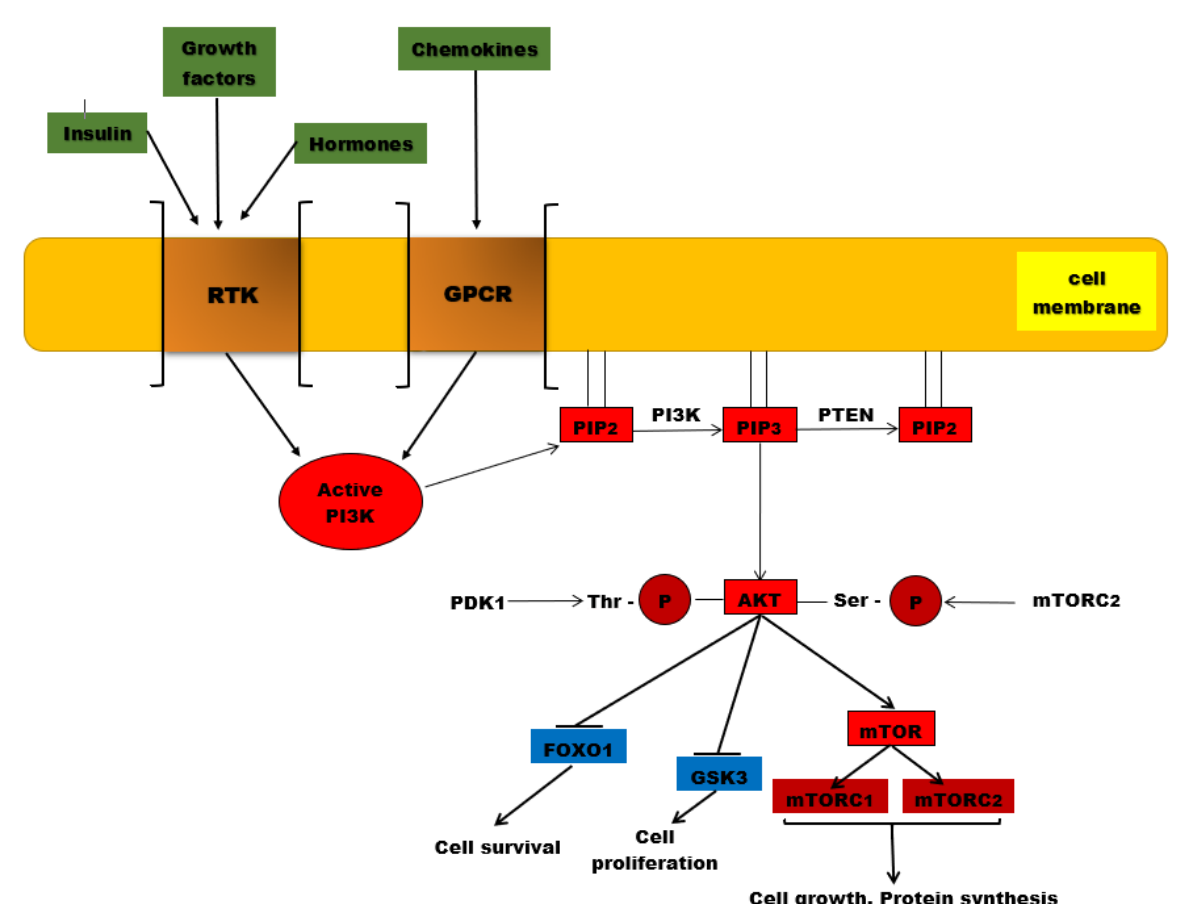
Figure 1. The PI3K/AKT/mTOR signaling pathway. PI3K is activated by the binding of ligands (insulin, growth factors, hormones) to RTKs, but also to GPCR (chemokines). Once activated, this protein kinase will catalyze the phosphorylation of PIP2 to PIP3. AKT is recruited to the plasma membrane where it undergoes two phosphorylation processes, one catalyzed by PDK1 at the level of threonine residue and the second reaction being catalyzed by mTORC2. Once activated by phosphorylation, AKT will phosphorylate other substances such as the mTOR complex, which will be associated in the end with protein synthesis and cell growth. Other phosphorylated substrates, such as GSK-3 and Fox01, will be inhibited, associated with cell proliferation and survival. PTEN is the major negative regulator of this signaling pathway involved in PIP3